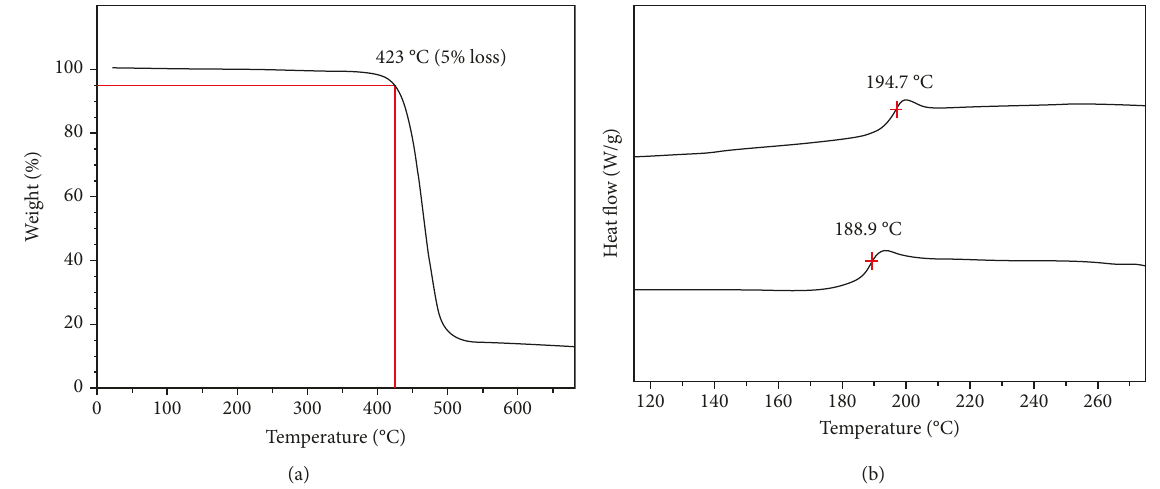
Figure 6: (a) TGA curve of polymer sample 2 . (b) DSC curves of polymer samples 1 (A) and 2 (B).